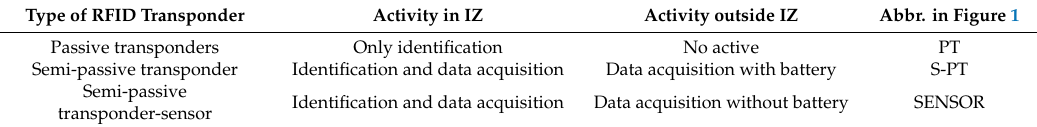
Table 1. Comparison of RadioFrequency Identification (RFID) transponder types. IZ—Interrogation Zone; PT—Passive Transponders, S-PT—Semi-Passive Transponder, SENSOR—Semi- Passive Transponder-Sensor. Type of RFID Transponder Activity in IZ Activity outside IZ Abbr. in Figure 1 Passive transponders Only identification No active PT Semi-passive transponder Data acquisition with